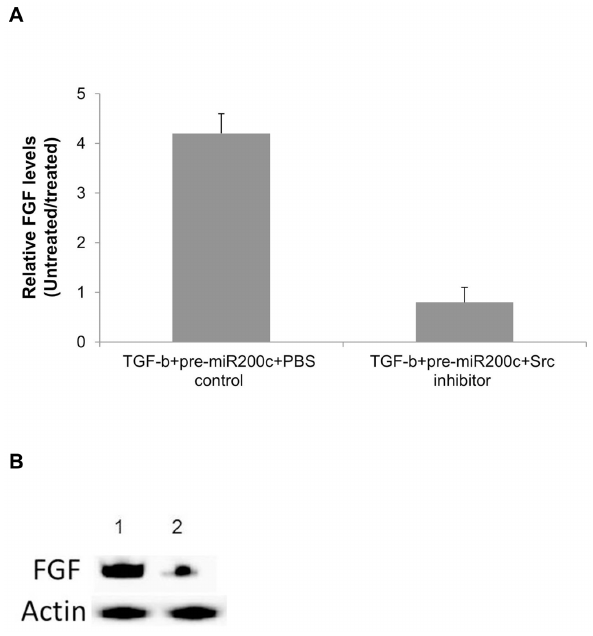
Figure 6. Src Inhibition reverses the action of miR200c. Human liver fibroblasts transfected with miR200c were stimulated with TGF- b in the presence of Src inhibitor (10 m M) or PBS control. a) Expression levels of FGF were analyzed at the protein level by western blot analysis. Bars represent the mean relative expression observed in 3 different set of experiments performed with 3 different fibroblasts. b) representative western blot analysis of FGF levels. Treatment with Src inhibitor decreased the levels of FGF expression in the miR200c transfected cells to the levels observed in the untransfected fibroblasts.